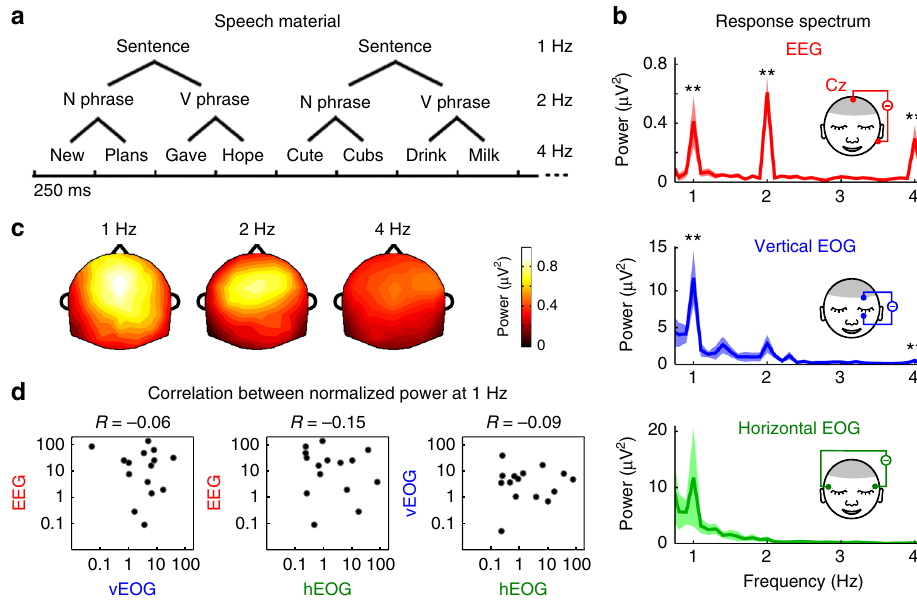
Fig. 1 Tracking of spoken sentences in EEG and EOG. a The speech material consists of a sequence of four-word sentences (monosyllabic words), which can be decomposed into a two-syllable noun phrase followed by a two-syllable verb phrase. The syllables are presented at a constant rate of 4 Hz, and therefore the presentation rates of phrases and sentences are 2 and 1 Hz, respectively. English words are shown in the illustration but the actual speech materials are in Chinese. b The EEG spectrum (channel Cz) shows three peaks of similar magnitude at the sentential, phrasal, and syllable rates (1, 2, and 4 Hz, respectively). The vertical EOG shows a clear sentential-rate response and a very weak syllabic-rate response. The horizontal EOG also shows a sentential-rate response peak but this response shows large individual variability and does not reach statistical signi fi cance. The signi fi cance of the spectral peaks is evaluated using bootstrap (the P -value, mean, and SEM reported in Supplementary Table 1). The shaded area covers 1 SEM across participants ( N = 15) on each side, evaluated by bootstrap (same for plots of spectrum/waveform in other fi gures). In the illustration, the reference electrode is placed on one side but in the analysis the signal is referenced based on the average mastoid recording from both sides. c The topography of the EEG response shows a fronto-central distribution. d Sentential-rate response power is not correlated across the three measures, i.e., EEG, vertical EOG, and horizontal EOG (correlation not signi fi cantly larger than 0, P = 0.65, 0.75, and 0.73, respectively, one-sided bootstrap, not corrected for multiple comparisons). The power at each frequency is normalized by dividing the power averaged over two neighboring frequency bins. Each black dot is the data from one individual. * P < 0.05; ** P <